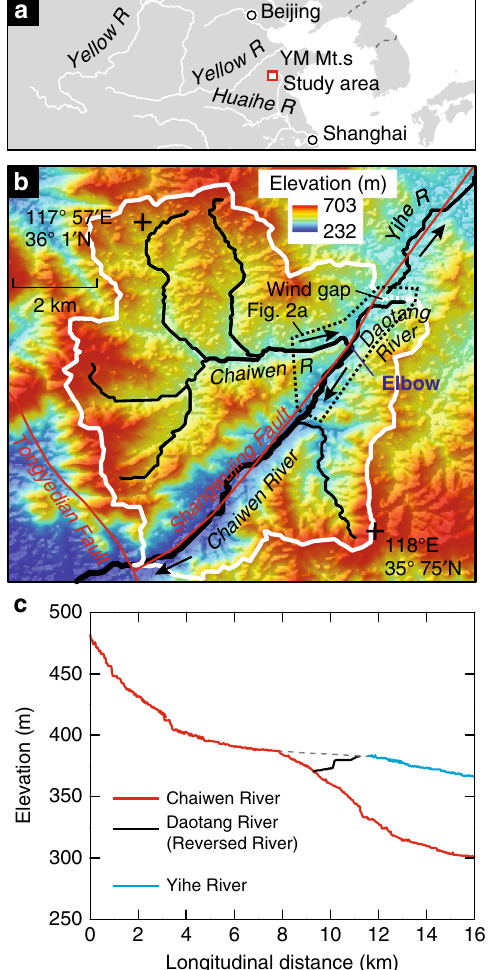
Fig. 1 Overview of the study area. a Location of the study area in China. b Shaded relief map showing elevations within the study area; the white line is the boundary of the upstream portion of the Chaiwen River Basin, and the lowest saddle in the divide between Daotang and Yihe Rivers (wind gap) is indicated as a dashed line. The red solid lines are faults and the dashed area around the elbow is shown in detail in Fig. 2. c Longitudinal pro fi les of the Chaiwen, Yihe, and Daotang Rivers. The dashed line is a hypothesized longitudinal pro fi le of the paleo-channel that connected the upper Chaiwen River to the Yihe River before the capture event, and entrenchment and reversal of the Daotang River. The data for b and c are from ref.